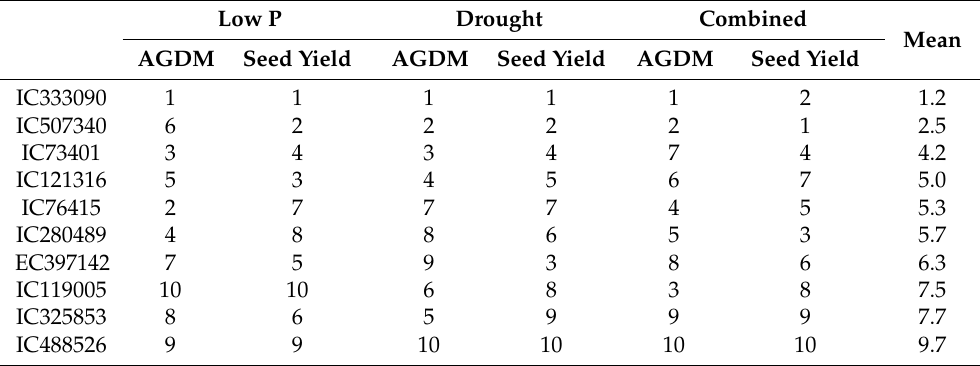
Table 2. Stress susceptibility indices (SSI) of 10 selected mungbean accessions based on the above ground dry matter (AGDM) and seed yield. Rank 1 is the best performer, while rank 10 is worst performer.